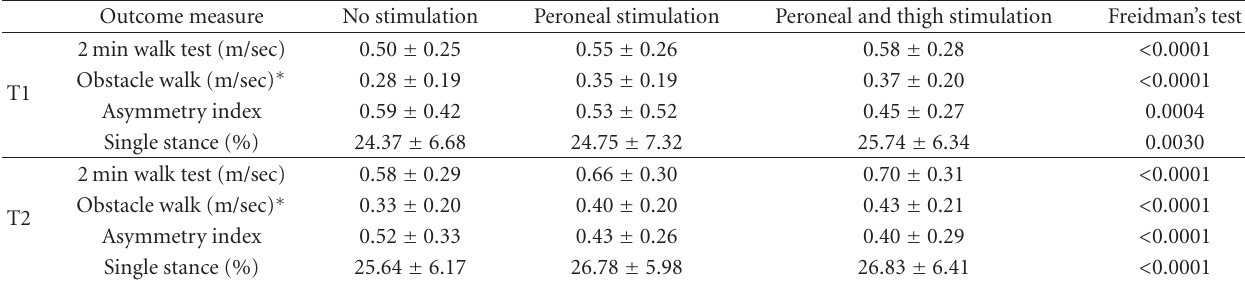
Table 1: Group means, standard deviations of all measured gait performance variables, and results of analysis of Freidman’s test.